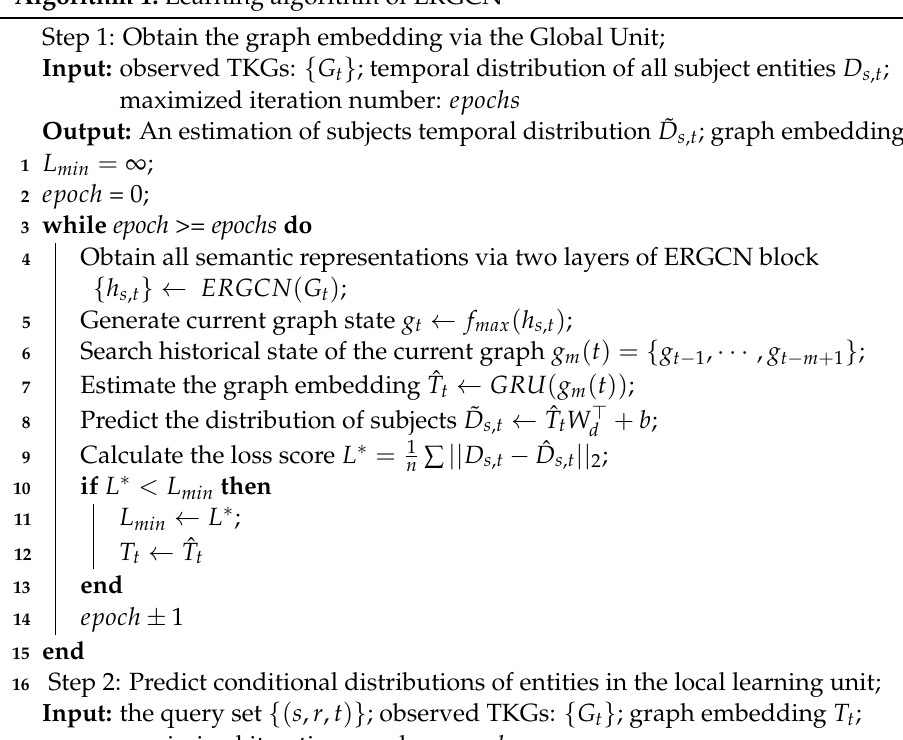
Algorithm 1: Learning algorithm of